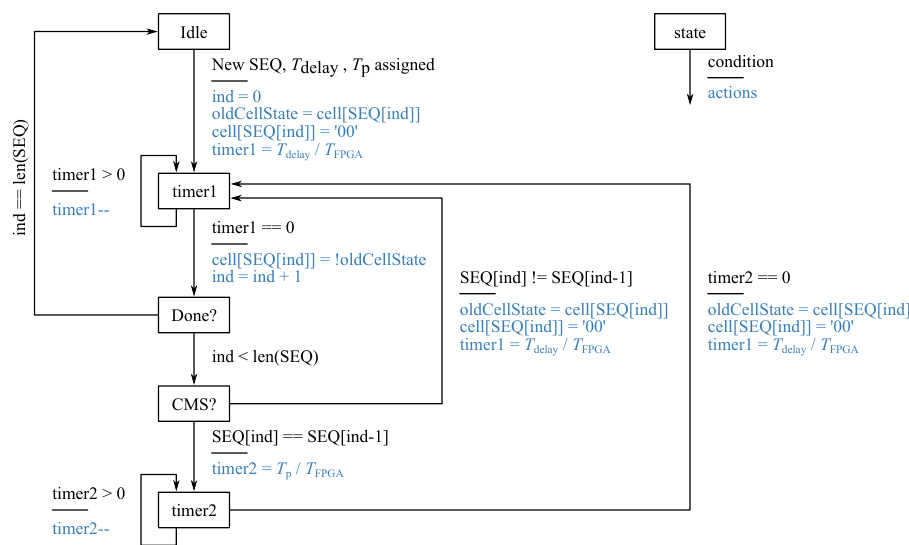
Figure 7. Detailed state machine of the modulator shown in Figure 6a. Cell[ i ] stores the two gate signals of the two switches of cell i ; T FPGA denotes the FPGA clock period. Note that T delay and T p are shown as scalars for simplicity (i.e., all commutations within one Q2L transition use the same values), but it would be possible to specify vectors indexed by ind such that individual values for each commutation could be